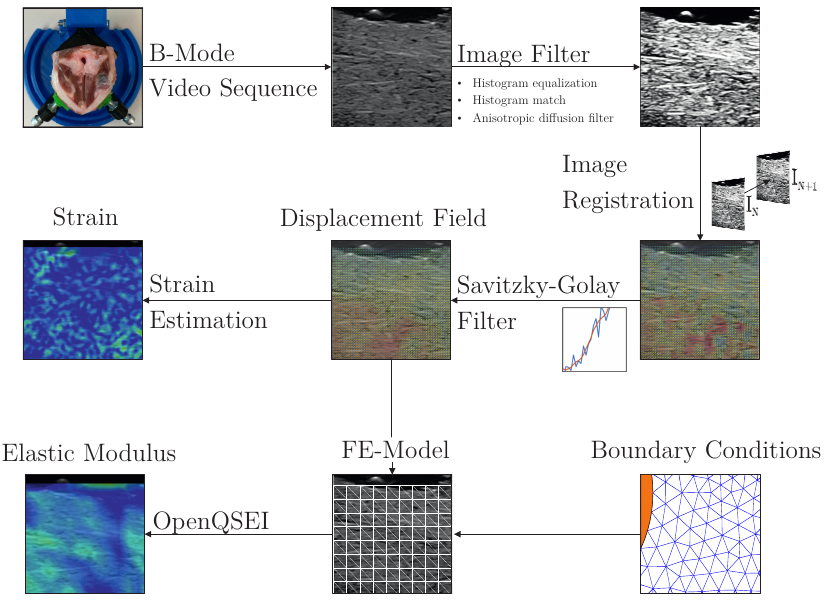
Figure 3. The data evaluation